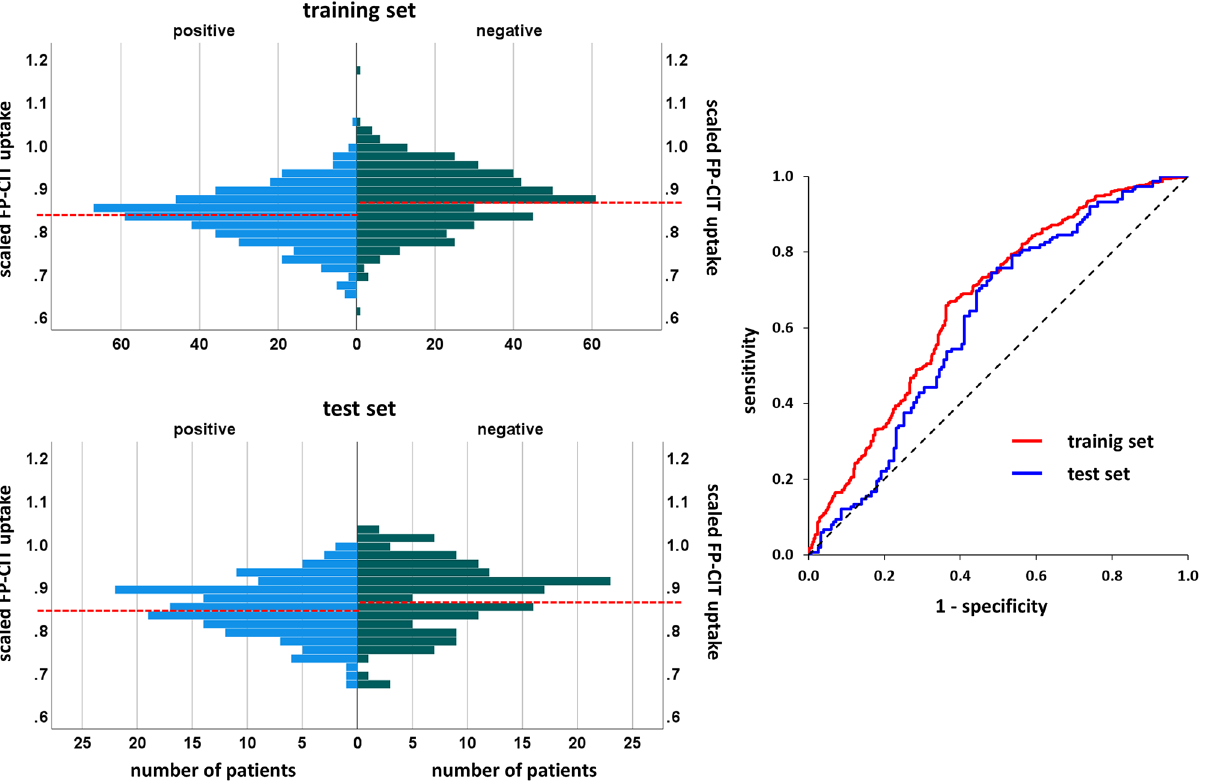
Figure 4. 123 I-FP-CIT uptake in the ipsilateral insula. Histograms and ROC curves of the 123 I-FP-CIT uptake in the relevance cluster in the ipsilateral insula region (Fig. 3) in the training set and in the test set. The dashed red lines in the histograms indicate their mean values.